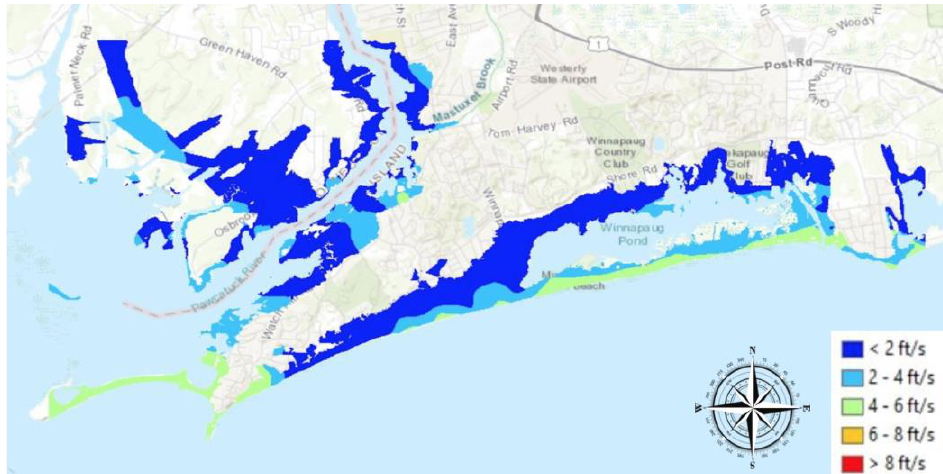
Figure 5. Contour map of model-predicted current speeds for 100 yr storm with 3.2 ft SLR.